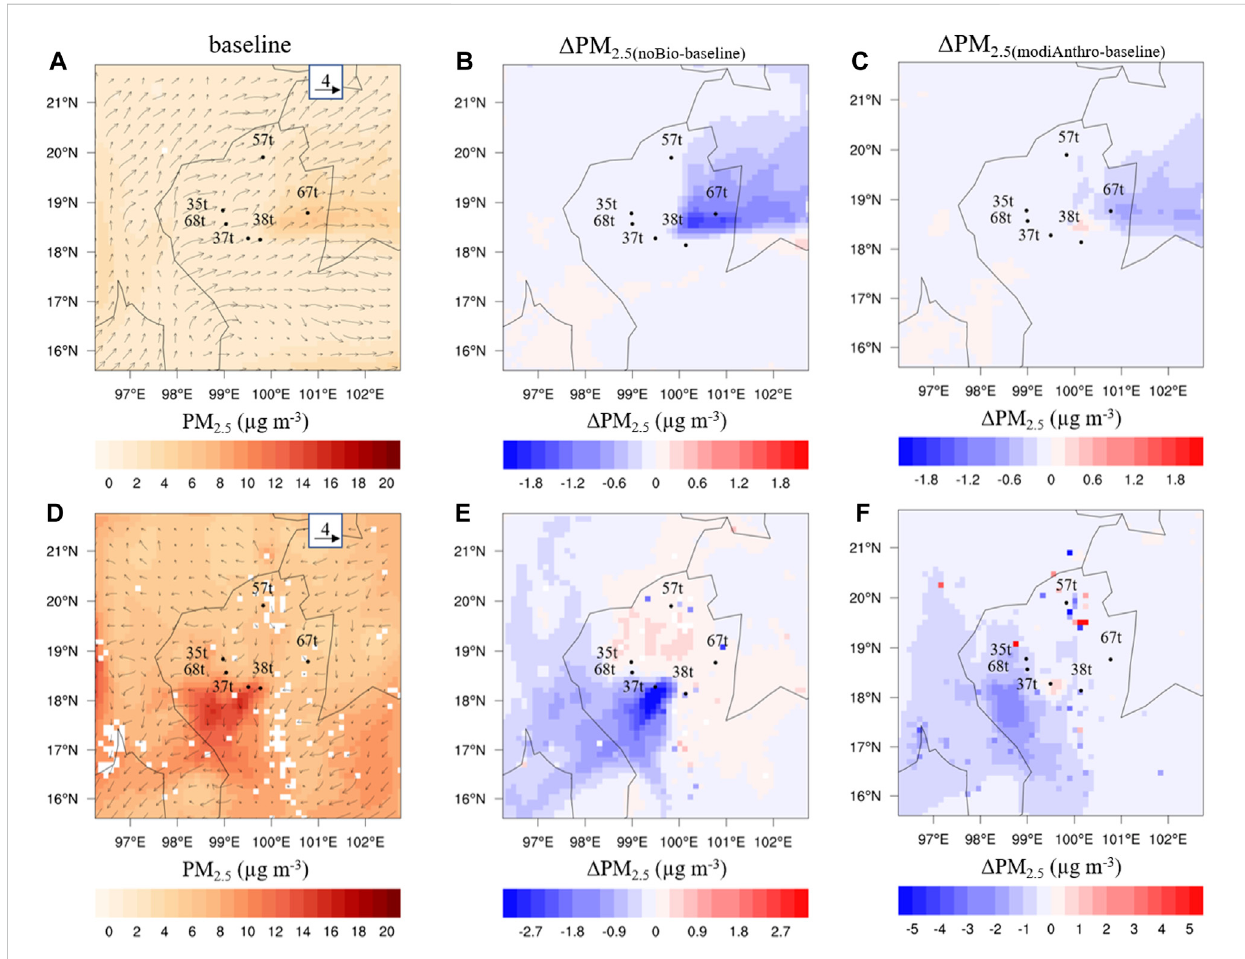
FIGURE 4 Spatial distribution of PM 2.5 from baseline simulation with wind vectors (1st column), spatial distribution of Δ PM 2.5(noBio-baseline) (2nd column), and Δ PM 2.5(modiAnthro-baseline) (3rdcolumn)duringtheperiodfrom16to23Juneof2021 (A of2021 (D – F) ,respectively.ReddishandbluishcolorsrefertoanincreaseinPM 2.5 andadecreaseinPM 2.5 concentrationcomparedtothePM 2.5 fromthe baseline simulations,